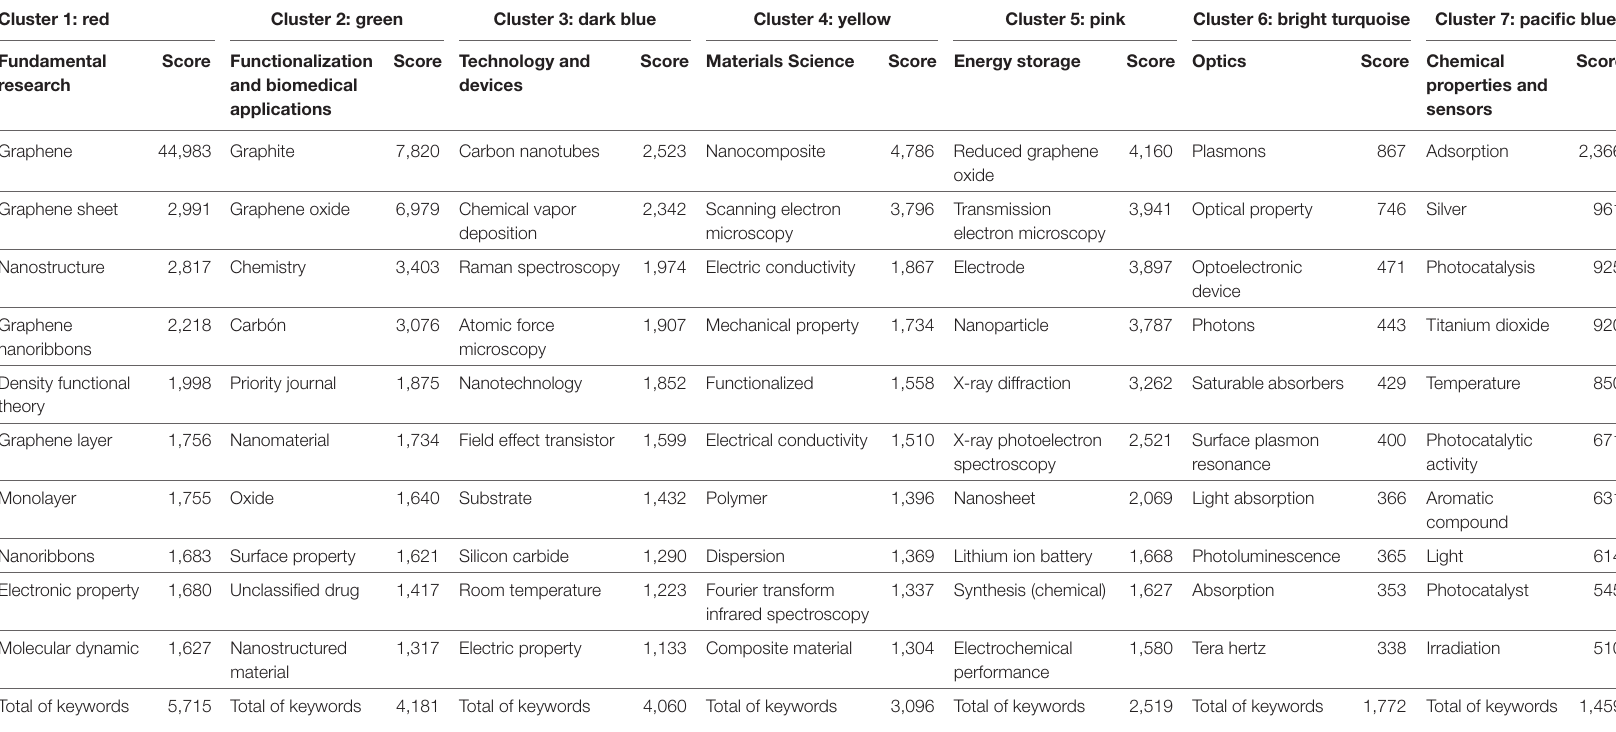
TaBle 3 | Research lines of graphene and descriptors. cluster 1: red cluster 2: green cluster 3: dark blue cluster 4: yellow cluster 5: pink cluster 6: bright turquoise cluster 7: pacific